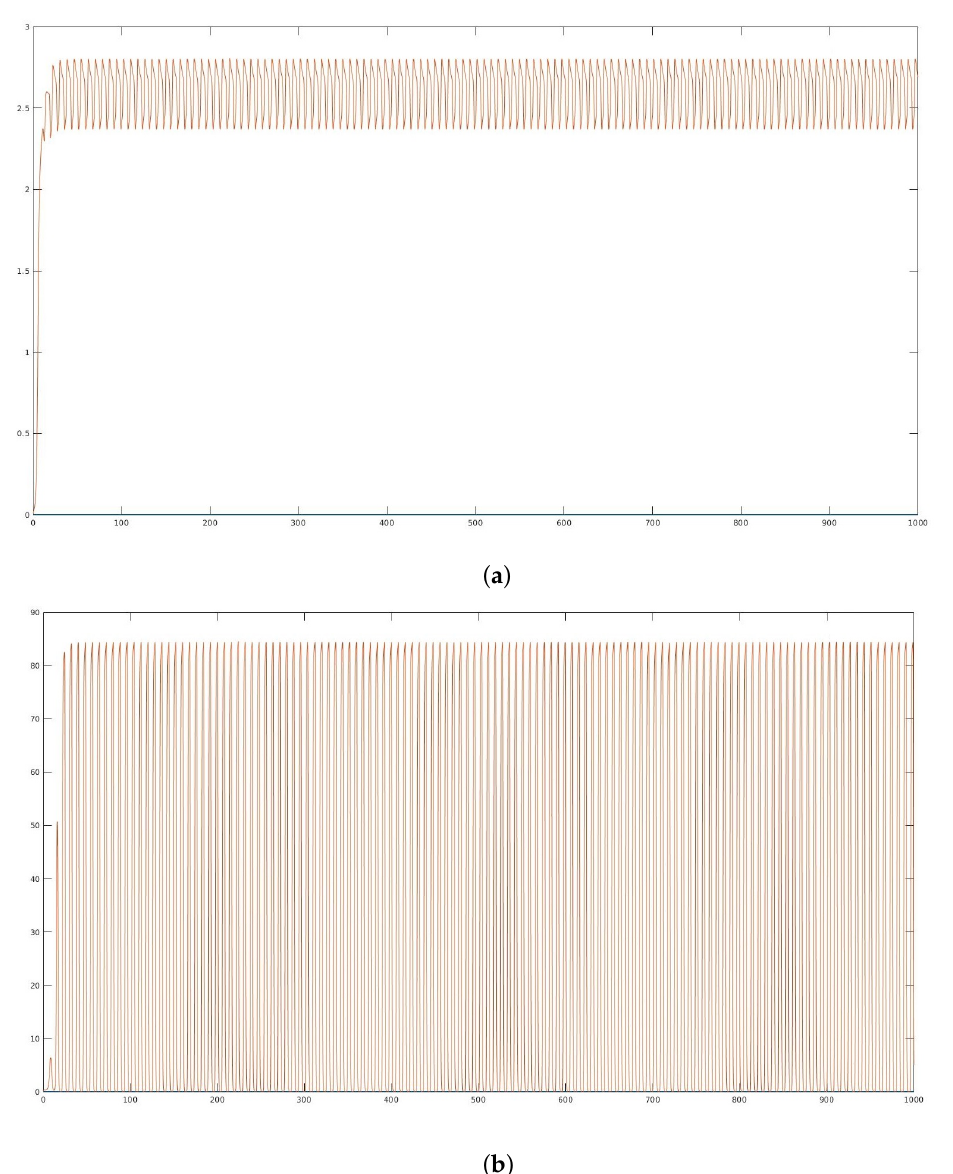
Figure 3. Stability of equilibrium point ˜ E 1 : ( a ) Evolution of the white blood cells’ precursors; ( b ) Evolution of the adult leukocytes The equilibrium point ˜ E 2 corresponds to a healthy state of the patient. Figure 4 shows the equilibrium point ˜ E 2 in blue and a small perturbation from this equilibrium point in red. The equilibrium point is clearly unstable, but the evolution of the patient is still promising. The white blood cells’ precursors and adult leukocytes both show an increase in number. Oscillatory trajectories are common in blood cell evolution, as there is a natural inner oscillatory